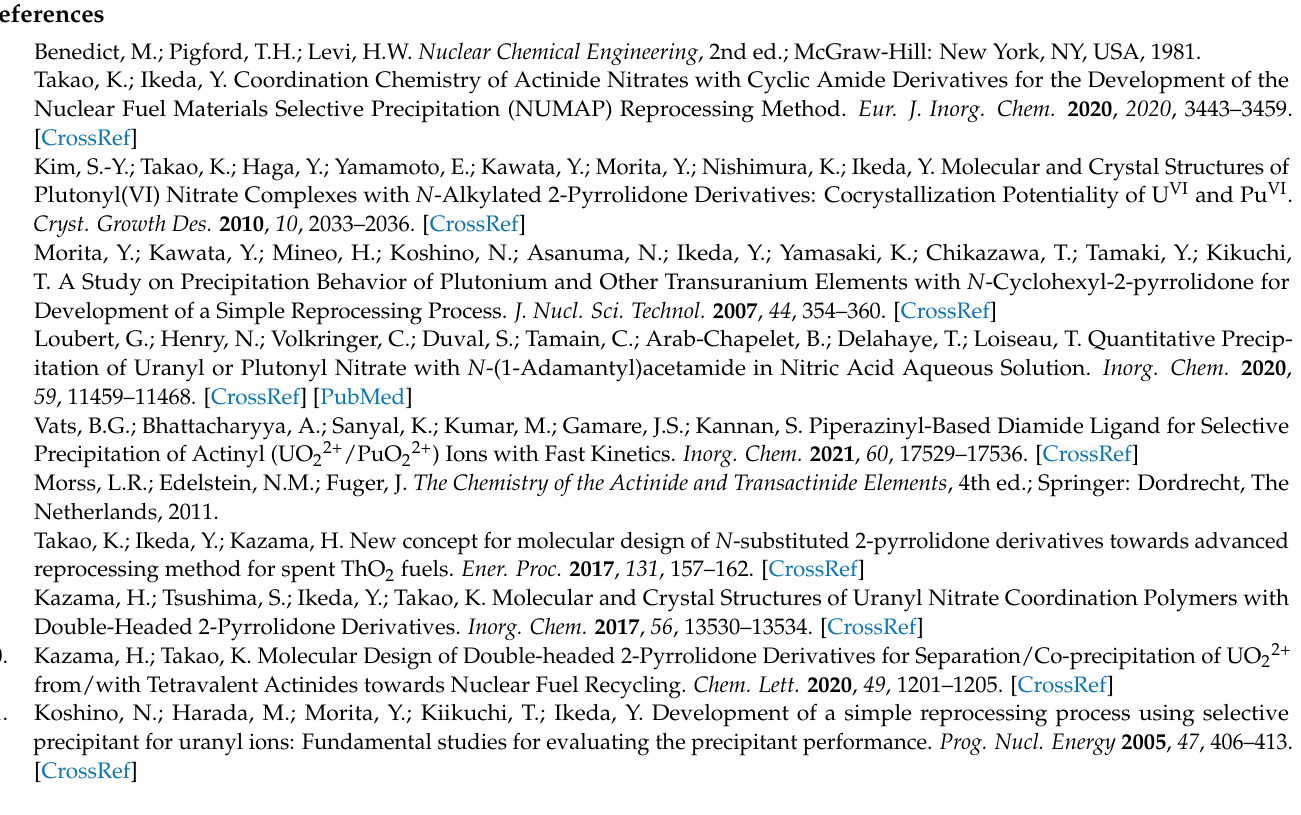
Table S1: Logarithmic stability constants (log β ) of typical actinyl(VI) complexes (AnO 2 (L) nm + ; An = U, Np, Pu; L = CO 32 − , CH 3 COO − , F − , Cl − , NO 3 − , SO 42 − ), in aqueous systems at 298 K and zero